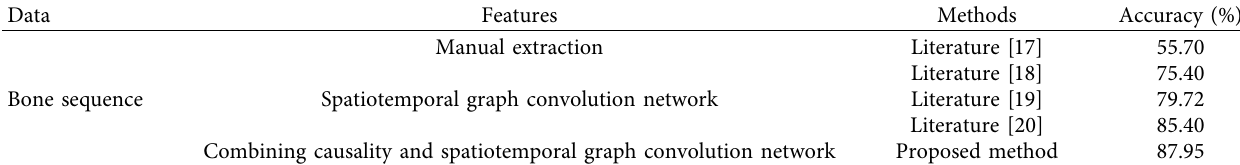
Table 2: Experimental results of northwestern-UCLA